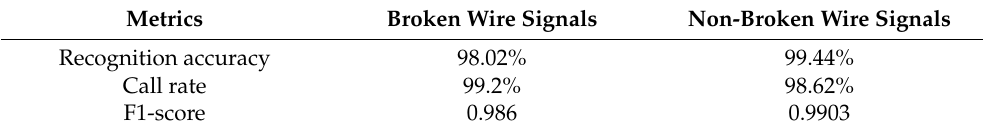
Table 6. The performance of LSTM (simulated signal for training, and measure signals for test set).